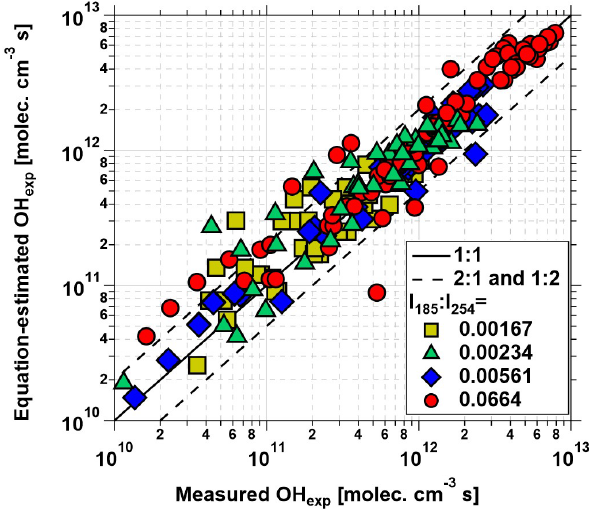
Figure 7. OH exp calculated from estimation equation (Eq. 1 and Ta- ble 2) as a function of OH exp calculated from tracer decay method for Hg lamp types with I 254 : I 254 values specified in the